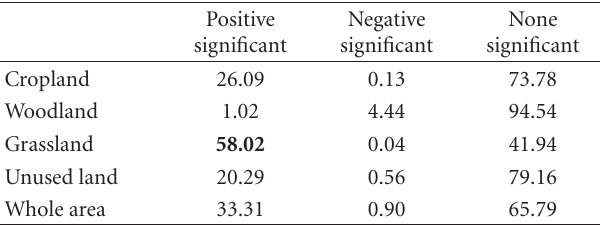
Table 2: The percentage of di ff erent correlations between inte- grated NDVI in the growing season and accumulated precipitation over the same period for each land use type to the total study area